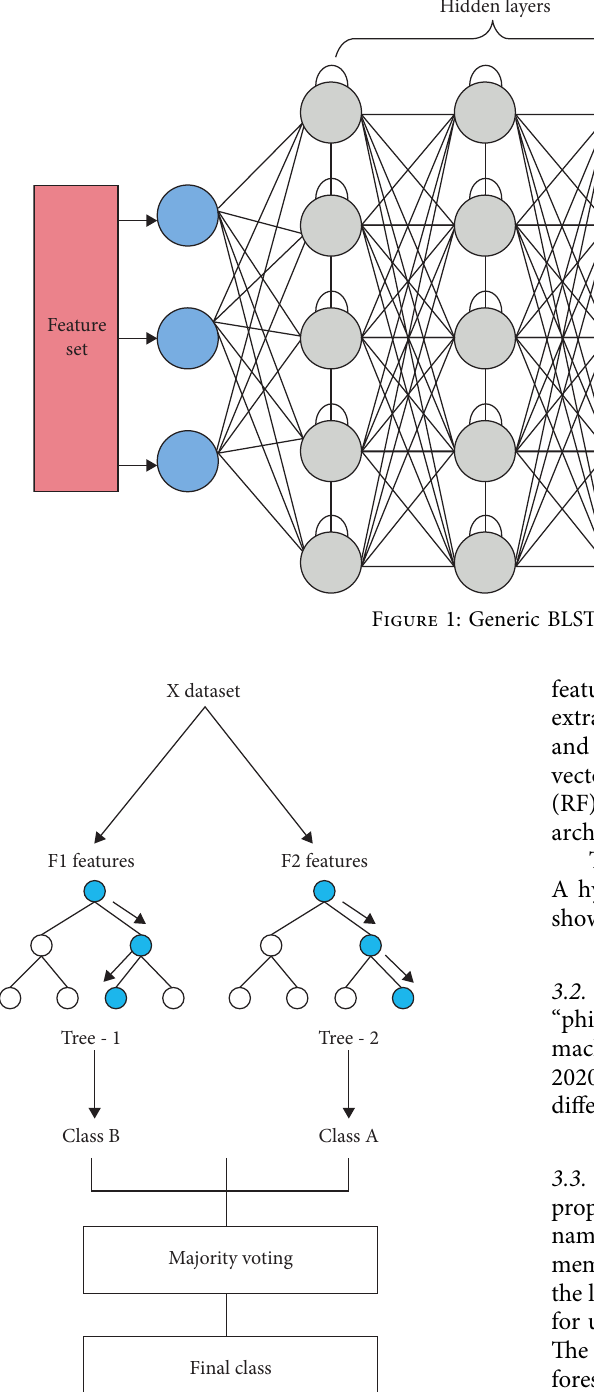
Figure 2: A conventional RF model for handwritten Pashto character recognition.